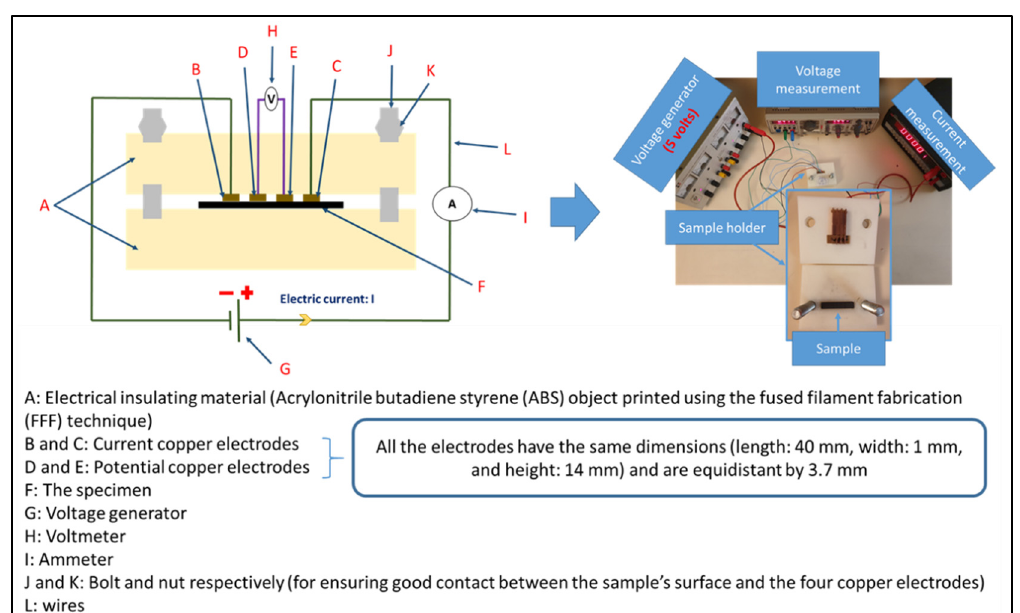
Figure 2. The setup of the electrical resistance measurement using the four probes method.